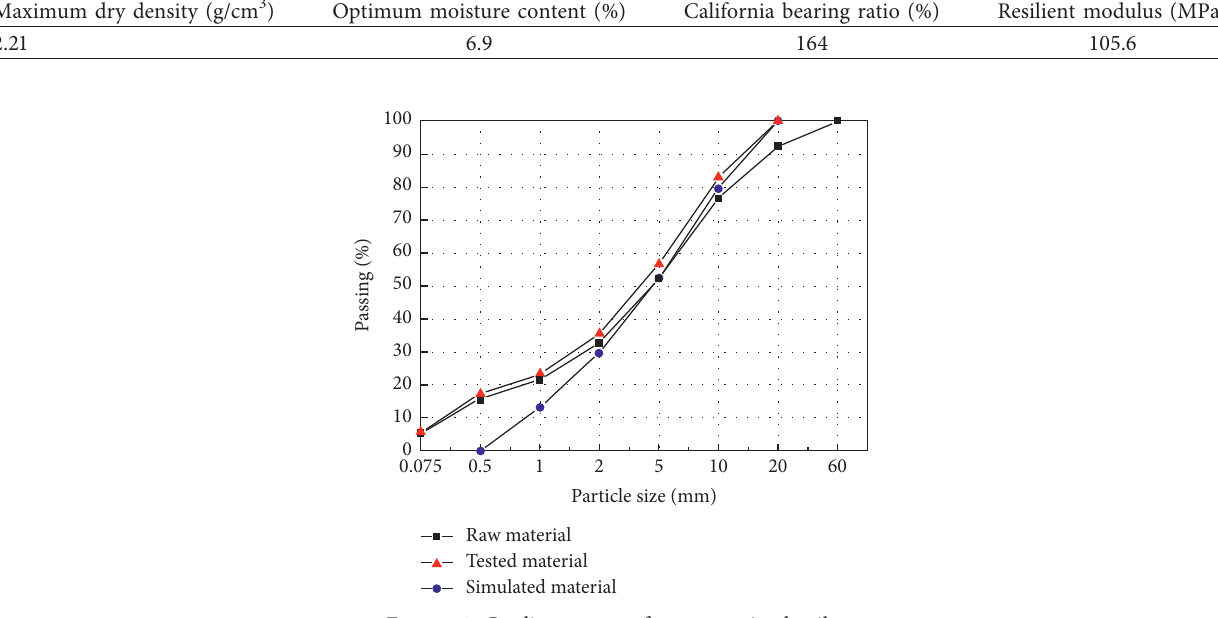
Figure 1: Grading curves of coarse-grained